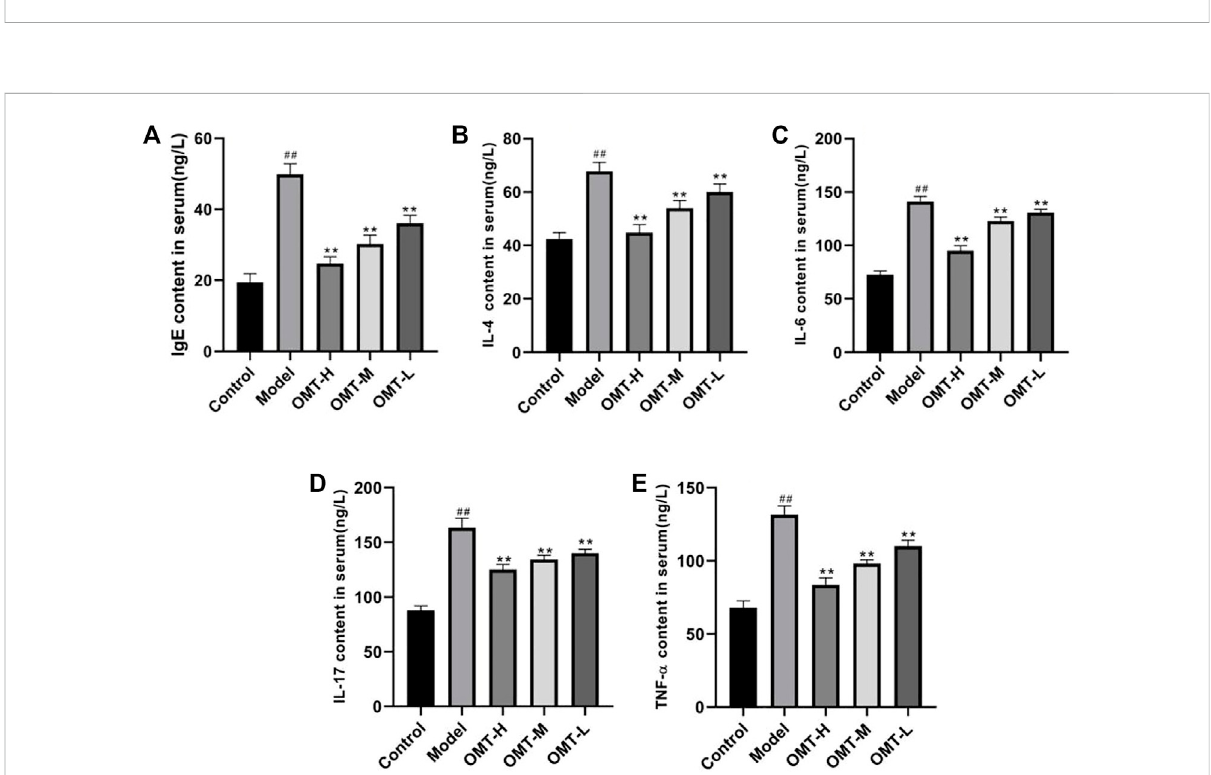
FIGURE 2 Comparison of (A) IgE, (B) IL-4, (C) IL-6, (D) IL-17 and (E) TNF- α levels in serum. ( ## , p < .01, vs. Control group; **, p < .01, vs. model